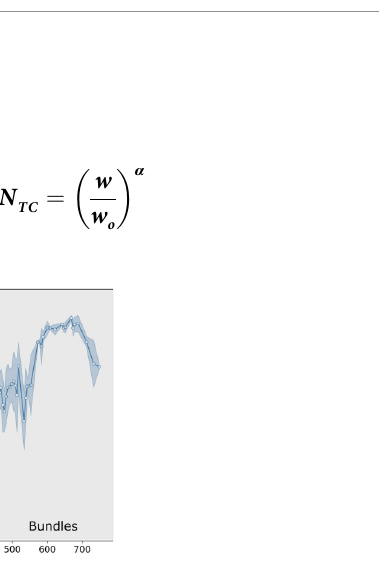
values (E) for the collagen fibrils in L